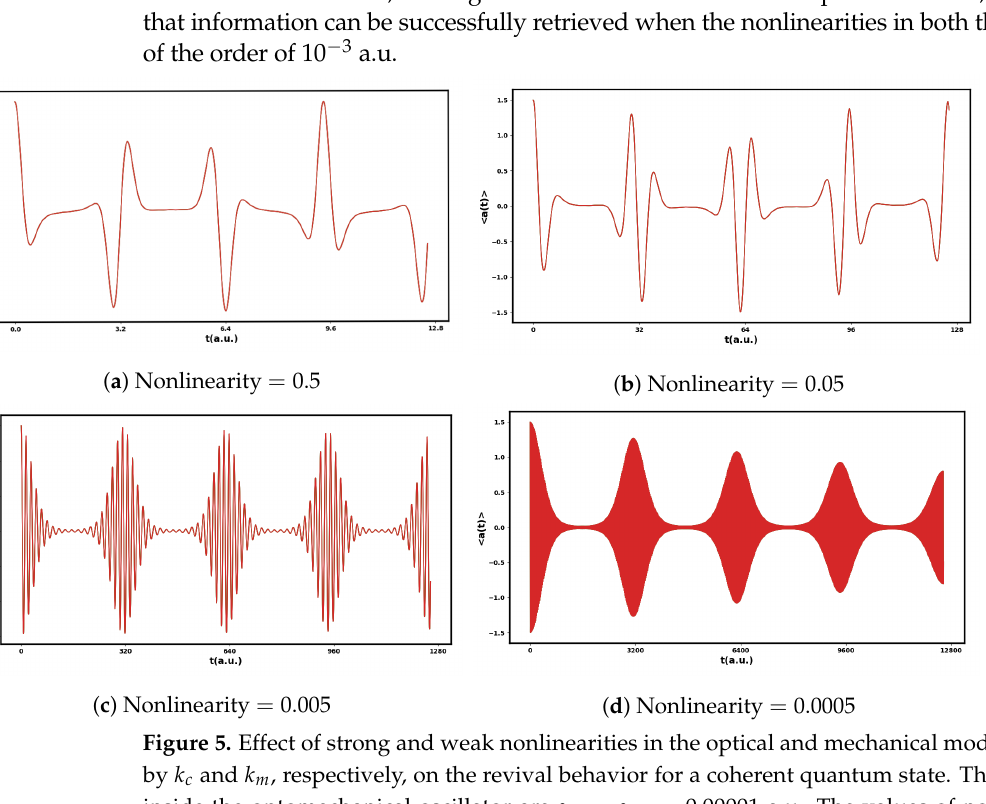
Figure 5. Effect of strong and weak nonlinearities in the optical and mechanical mode represented by k c and k m , respectively, on the revival behavior for a coherent quantum state. The dissipations inside the optomechanical oscillator are γ c = γ m = 0.00001 a.u. The values of nonlinearity are ( a ) k c = k m = 0.5 a.u., ( b ) k c = k m = 0.05 a.u., ( c ) k c = k m = 0.005 a.u. and ( d ) k c = k m = 0.0005